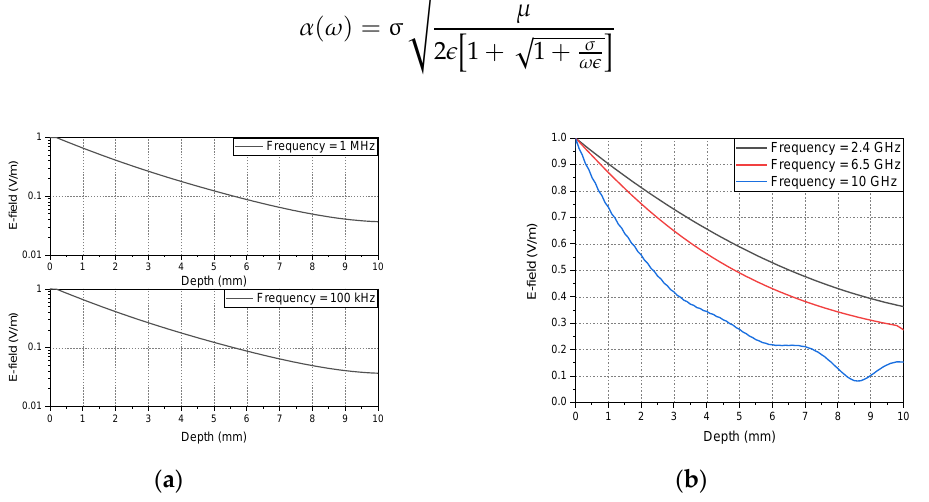
Figure 2. E-field attenuation in the brain tissue model for frequencies of ( a ) 100 kHz, 1 MHz, ( b ) 2.4 GHz, 6.5 GHz, and 10 GHz.